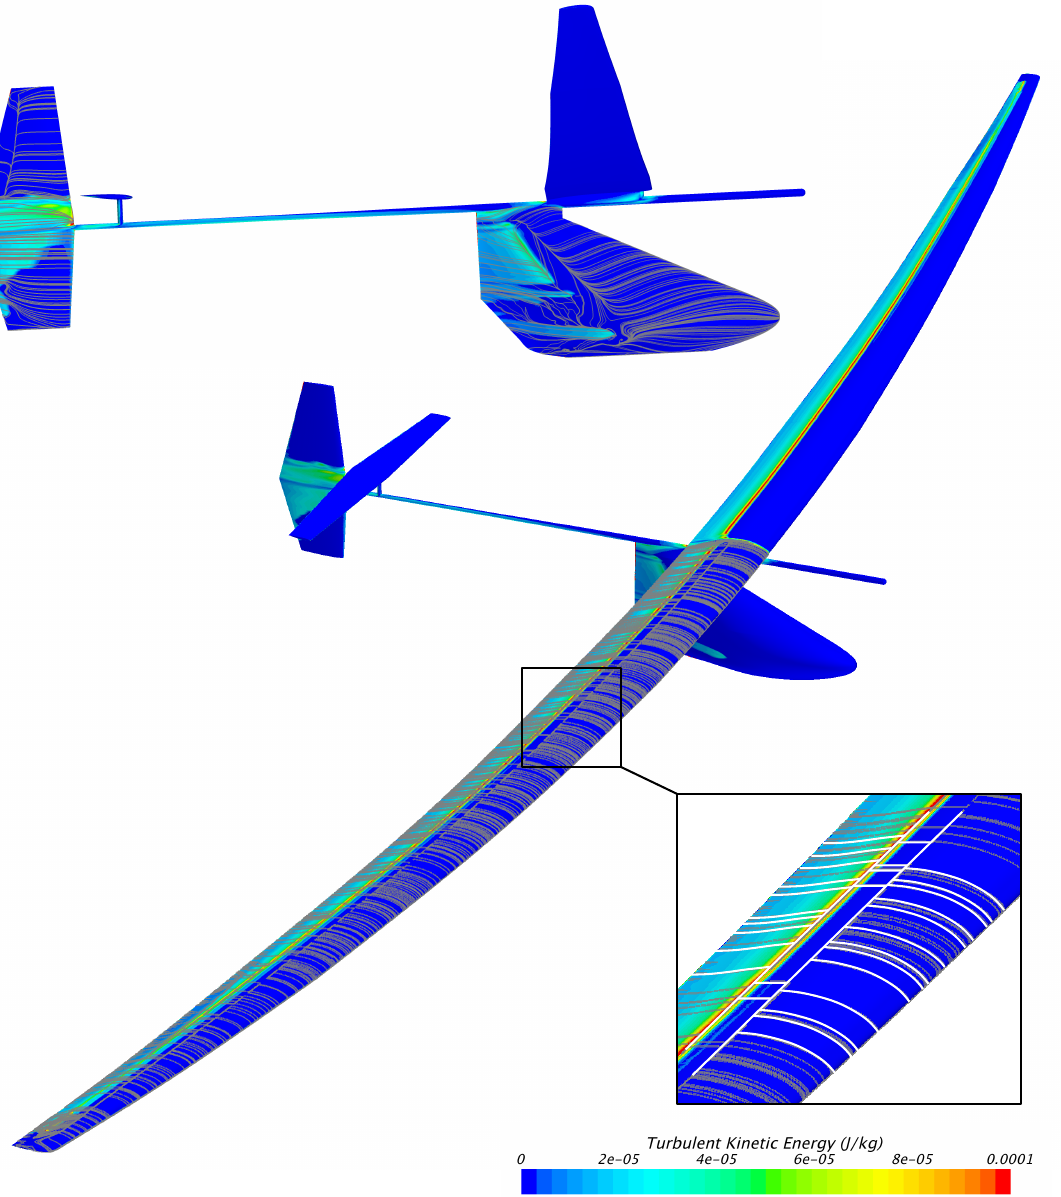
Figure 12. Transition from laminar to turbulent flow on the Daedalus visualized by the constrained streamlines and the turbulent kinetic